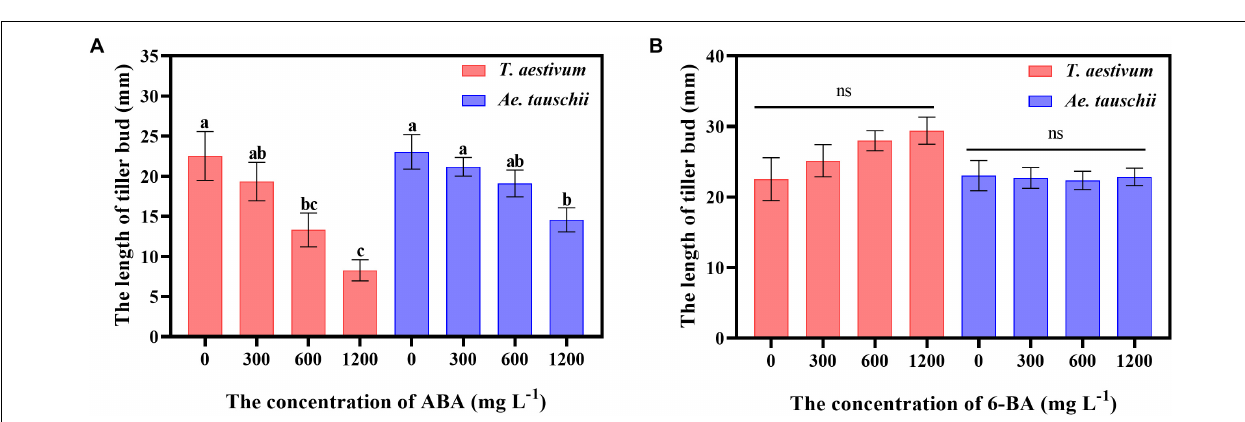
FIGURE 7 | The effects of external spraying of abscisic acid (A) and 6-benzyl aminopurine (B) on tiller bud outgrowth in T. aestivum and Ae. tauschii . Error bars represent the mean ± SD ( n = 3). Different letters represent significant differences (ANOVA, Student-Newman-Keuls test, P < 0.05, ns, no significant